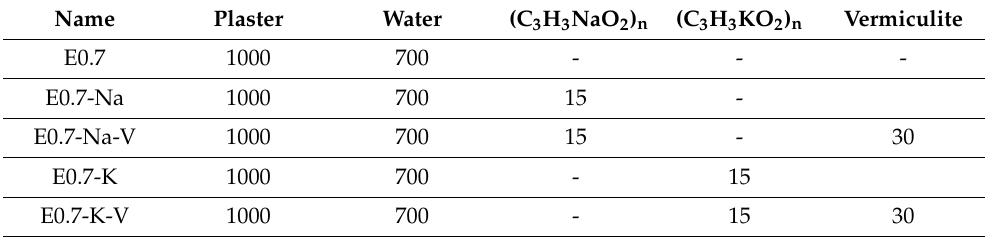
Table 3. Dosages used and composition. Weight in grams